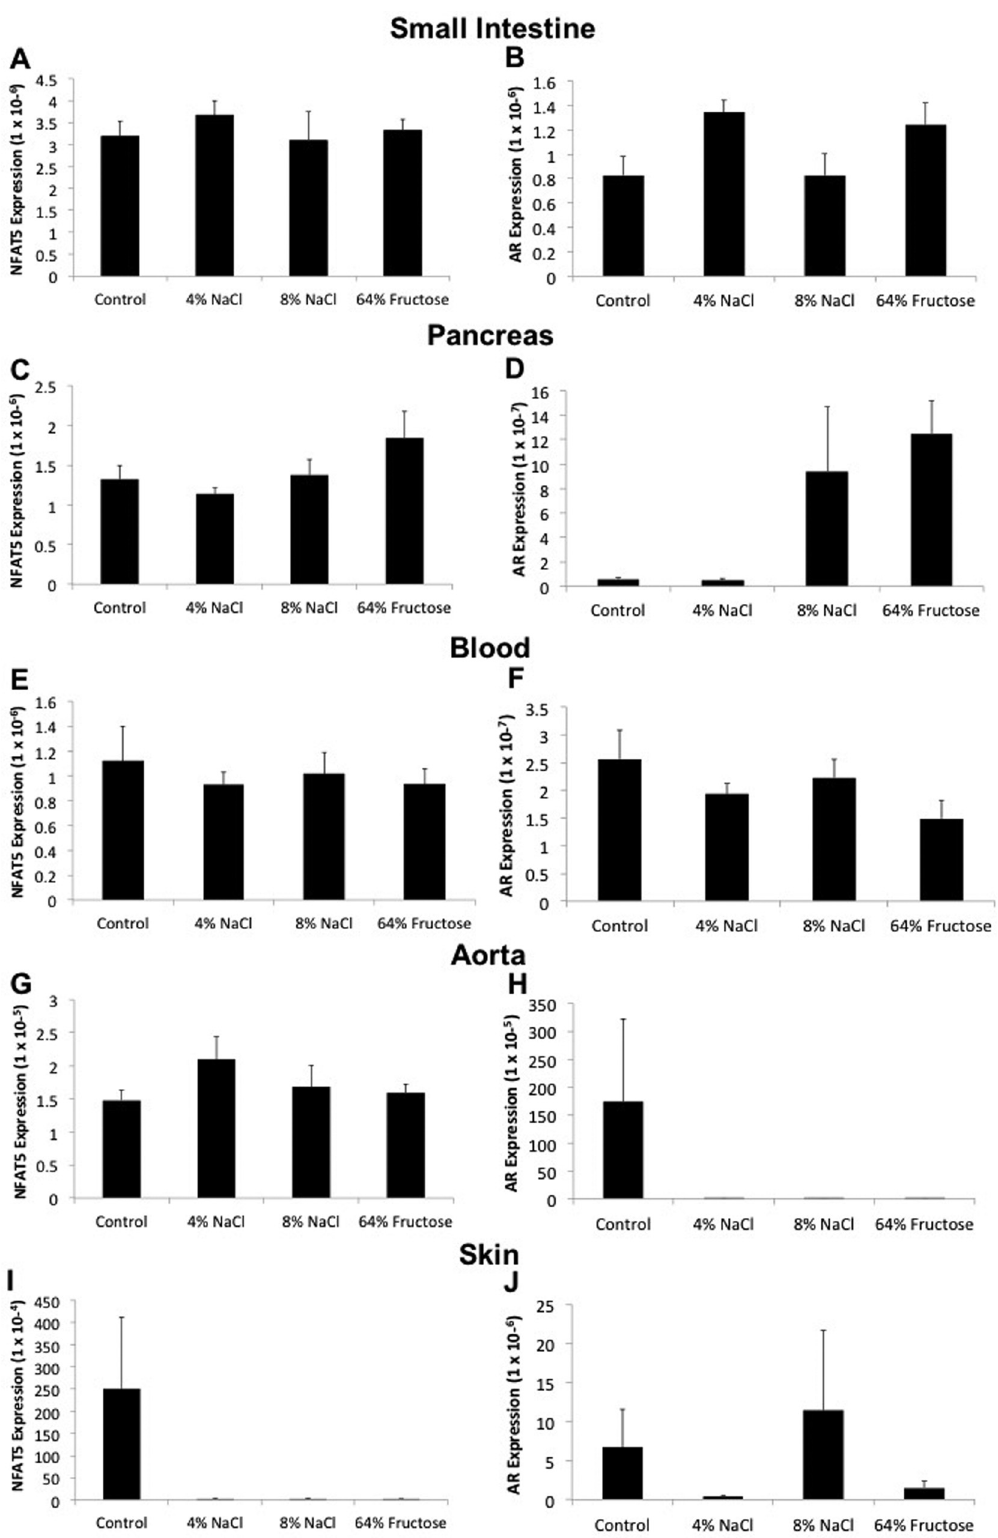
Figure 3 - NFAT5 and AR expression remain unchanged in the small intestine, pancreas, blood, aorta, and skin following 8-week administration of a 4% NaCl, 8% NaCl, and/or 64% fructose diet. Sprague-Dawley rats were fed a control (0.25% NaCl, 6% fructose), 4% NaCl, 8% NaCl, or 64% fructose diet for8weeks.Followingdietimplementation,tissuesampleswereharvestedandflashfrozen.RNAwasextractedandreverse-transcriptionwasperformed to generate cDNA. NFAT5 and AR primers were used to quantify gene expression in the small intestine, pancreas, blood, aorta, and skin. (n = 12-14 rats per diet